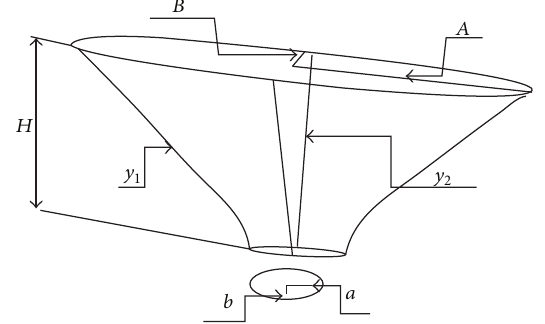
Figure 8: Geometrical parameters of an elliptical hyperboloid concentrator